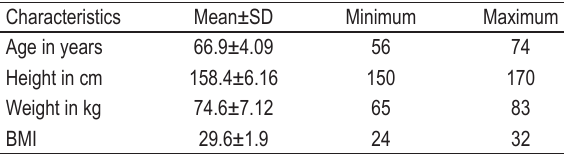
TABLE 1. Demographic characteristics of the sample ( n =139)